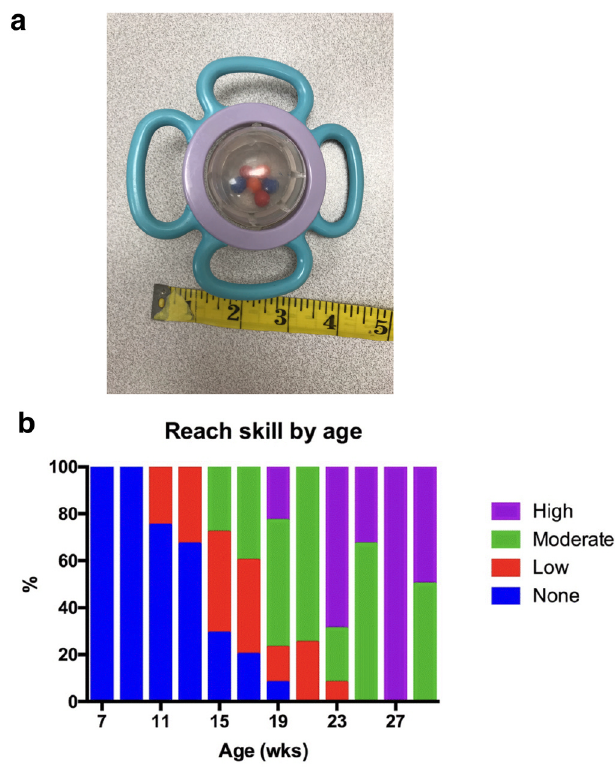
Figure 2. a . Object used in reaching skill assessment, shown with a measuring tape showing inches. Toy was rigid plastic, with rotating clear plastic center globe with balls that made noise when toy was moved. b . Percentage of visits that were assessed at each skill level, by chronological